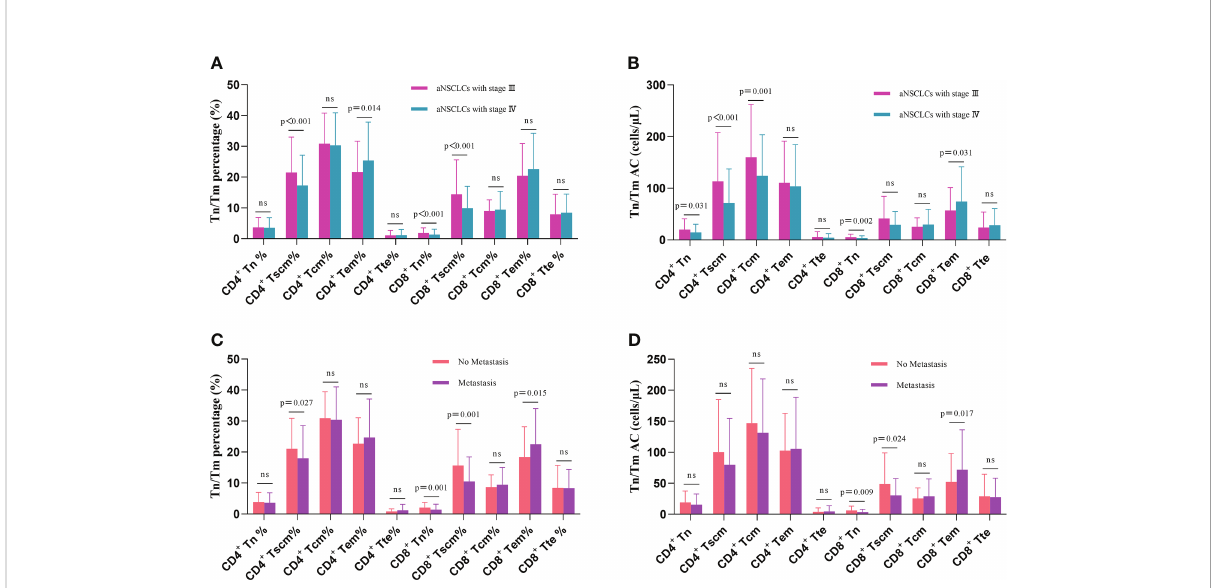
FIGURE 4 Comparison of Tn/Tm between different stages of aNSCLCs and aNSCLCs with or without metastasis: (A) Comparison of percentages between stages III and IV in aNSCLCs. (B) Comparison of AC between stages III and IV in aNSCLCs. (C) Comparison of percentages of aNSCLCs with or without metastasis. (D) Comparison of AC of aNSCLCs with or without metastasis. ns, no signi fi cance.